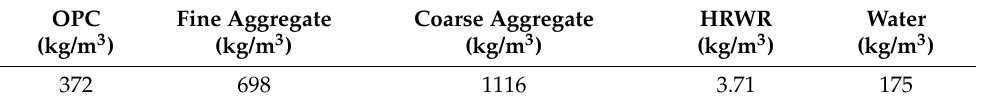
Table 1. Mix proportions of concrete.